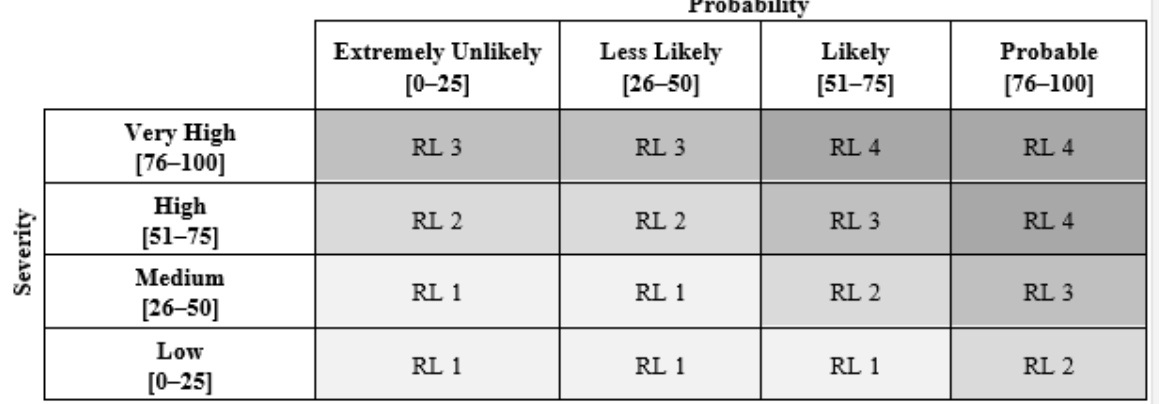
Figure 2. CB Nanotool risk level matrix, adapted from Zalk et al. [23].